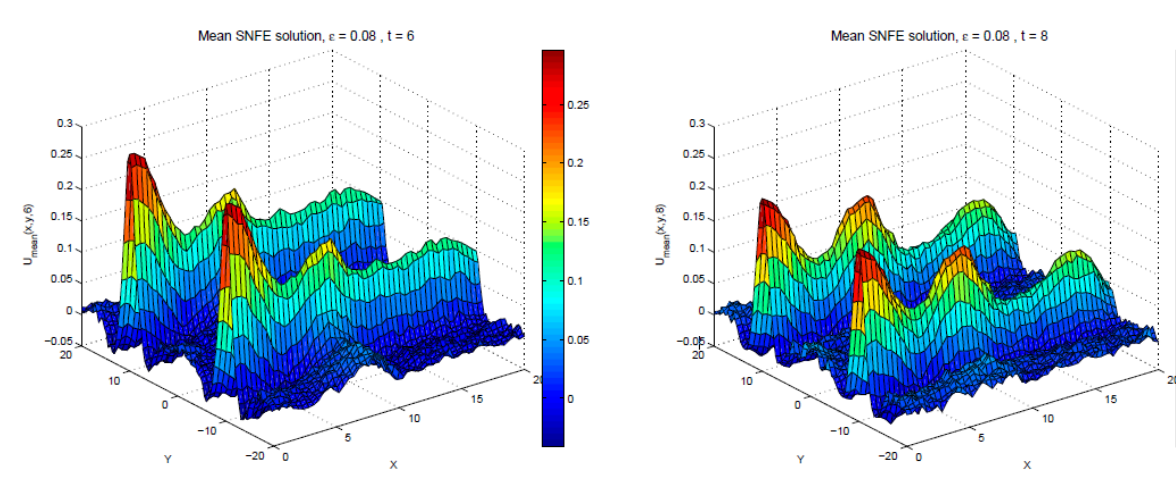
Figure 13. Snapshots of the solution of Example 3 at time t = 8: up- E = 0; down,left-hand side -E = 0.04; down, right- hand side - E =